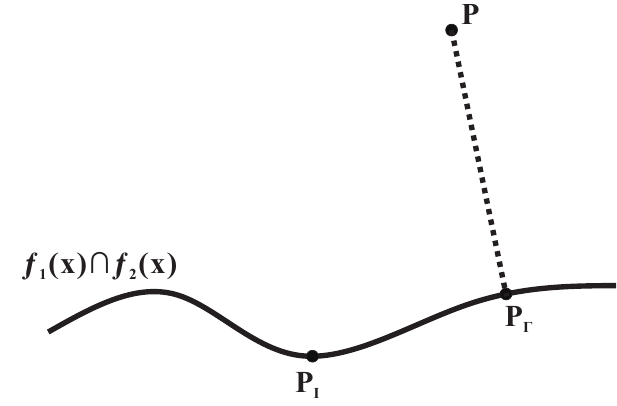
Figure 1. Test point P orthogonal projection onto a spatial algebraic curve C